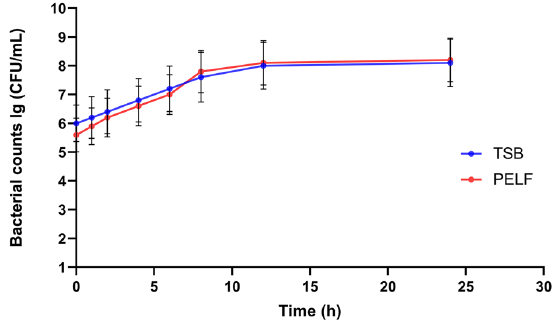
Fig. 3 The time-growth curves of APP BW1 in vitro (TSB, blue) and ex vivo (PELF,